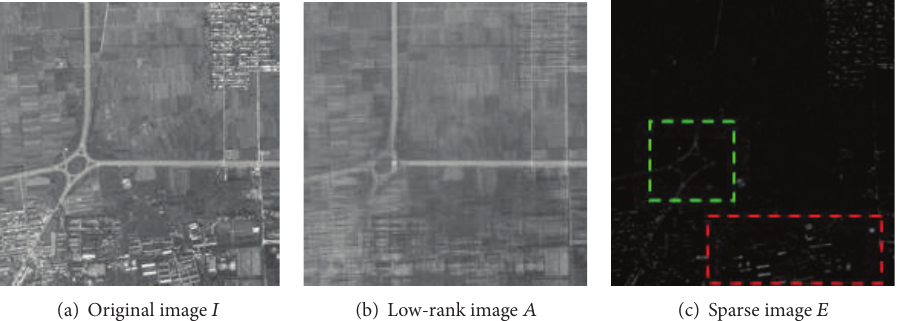
Figure 2: Low-rank matrix